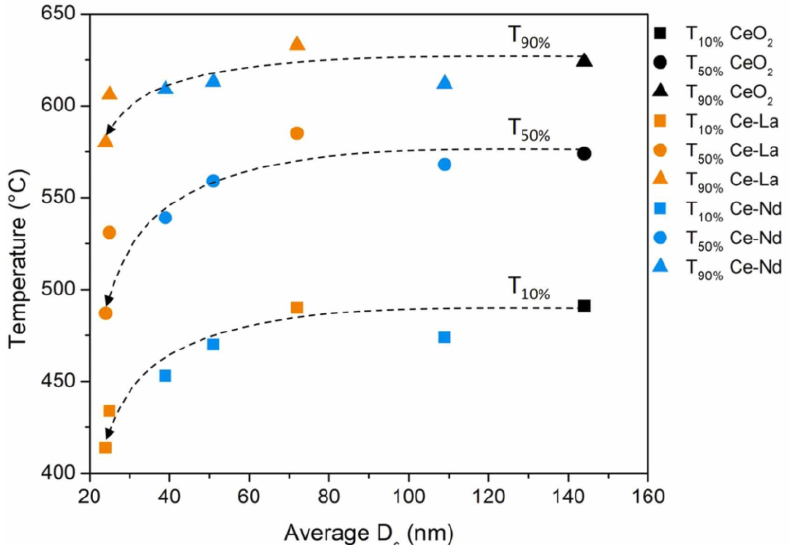
Figure 8. Variation of the catalytic performances as a function of the average crystallite size of the samples during soot oxidation in loose contact (the average of the two different D C values was used for La-doped ceria, Ce75Nd25 and Ce50Nd50; samples were named CeXReY, where Re is the doping rare earth (La or Nd) while X and Y are the atomic percentages of Ce and of the doping element, respectively). Reproduced with permission from Ref. [87]. Copyright© 2022, Elsevier.